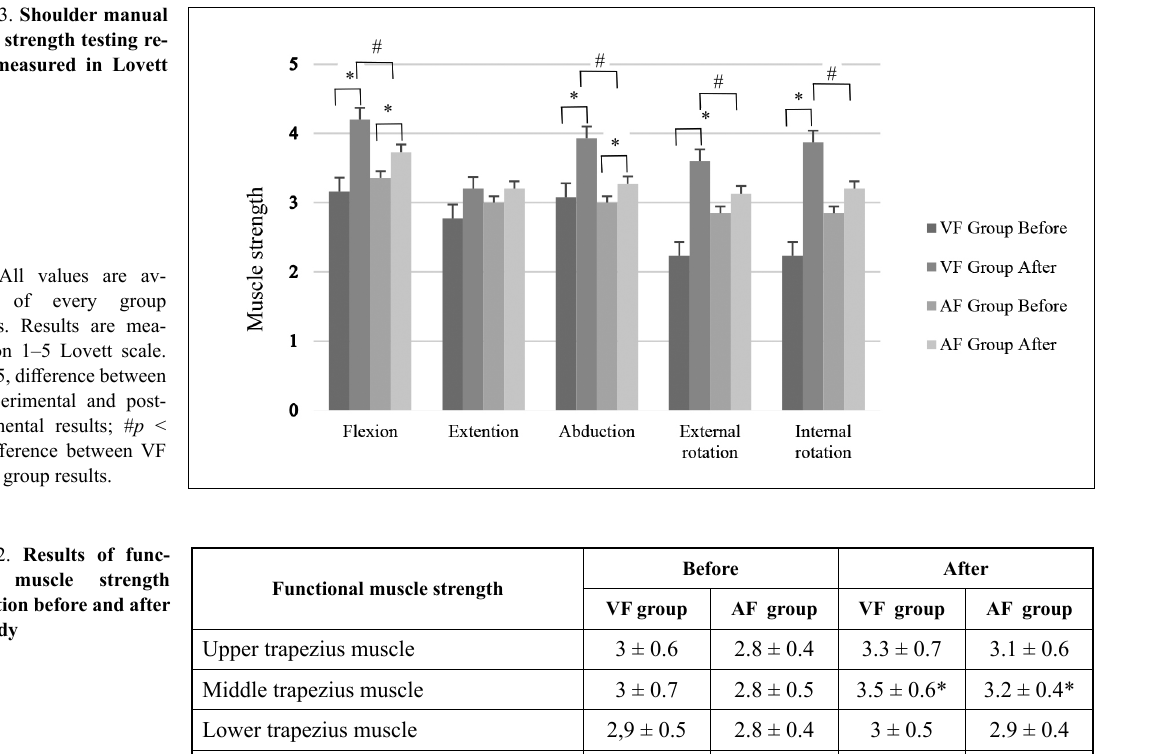
Figure 3. Shoulder manual muscle strength testing re- sults, measured in Lovett scale